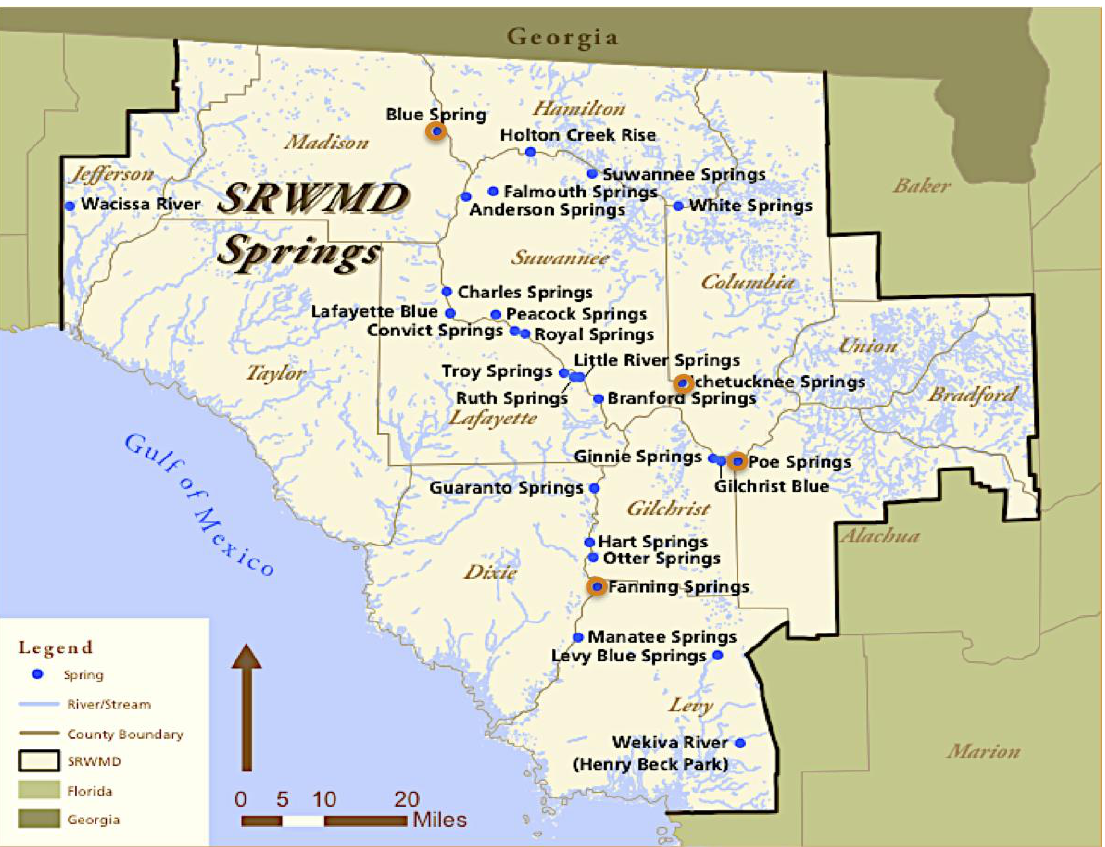
Figure 1. Springs of Suwanee and Santa Fe River Basin, Florida, U.S.A. Source. Ground Water